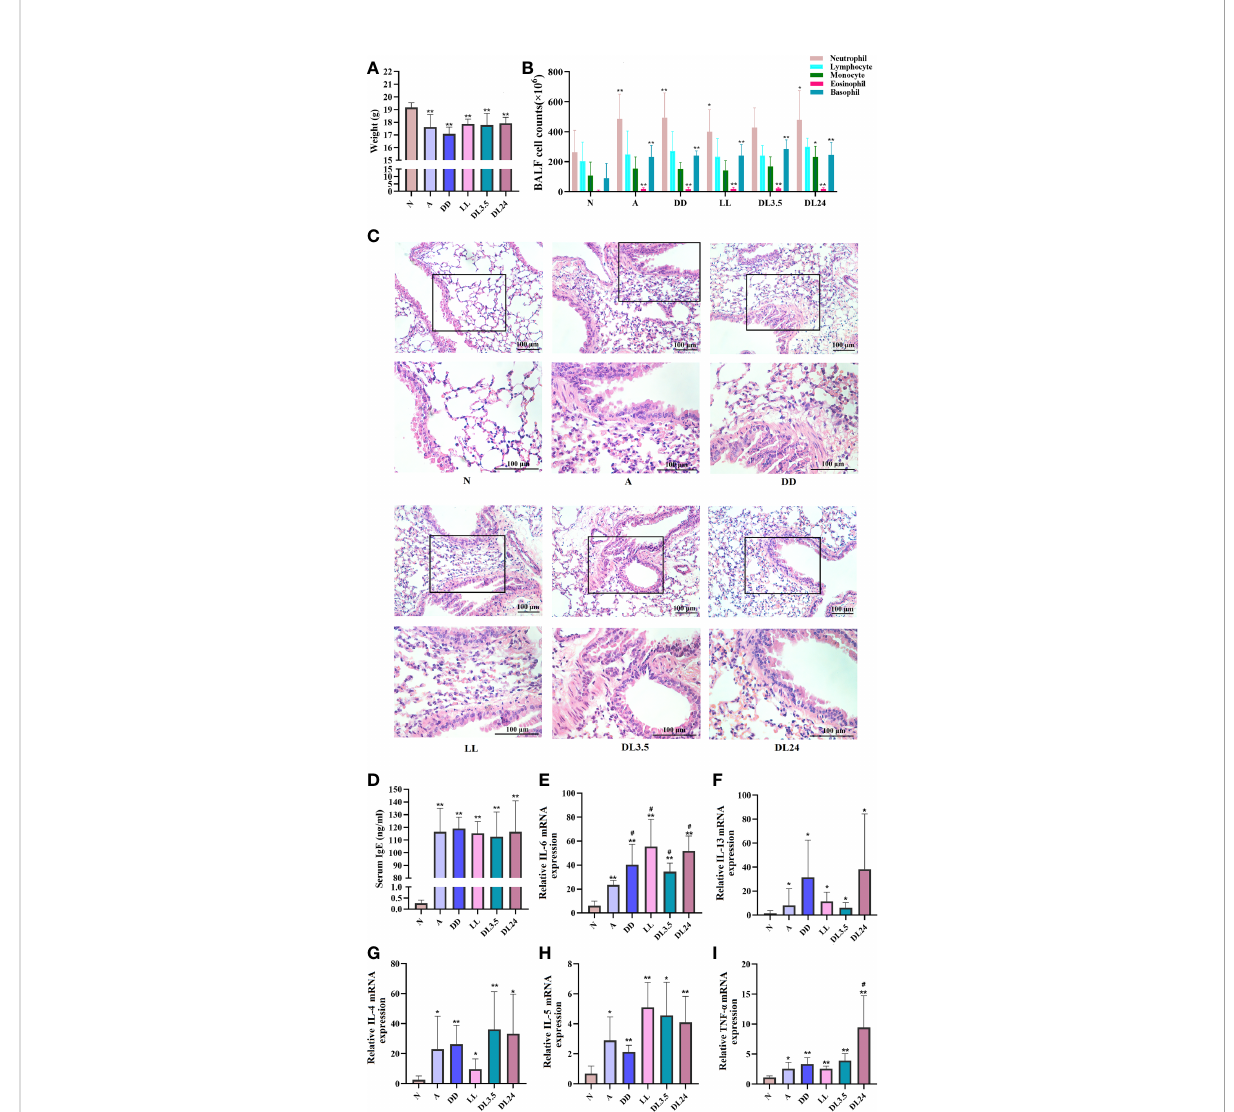
FIGURE 1 Effects of light-induced disturbances of rhythm on airway in fl ammation in the lung tissues of OVA-challenged mice. (A) Body weight variations at the end of the experiment in each group of mice. (B) Flow cytometric analysis of cell populations in the BALF of mice. (C) H&E staining of sections from OVA-challenged mouse lung tissue. Magni fi cation: 100× (upper panel) and 200× (lower panel). Scale bar: 100 m m. (D) ELISA analysis of IgE levels in serum. (E – I) RT-qPCR analysis of the mRNA levels of in fl ammatory cytokines (IL-6, IL-13, IL-4, IL-5, and TNF-a) in the lung tissue. N=control group; A=OVA group; DD=OVA + all-day darkness group; LL= OVA + all-daylight; DL3.5= OVA + 3.5 h dark/3.5 h light group; DL24= OVA + 24 h dark/24 h light group. All data are presented as the mean ± standard error of the mean (SEM) of 6 mice per group, * p < 0.05, ** p < 0.01, compared with the control group. # p < 0.05. One-way ANOVA with Tukey ’ s multiple comparison analysis